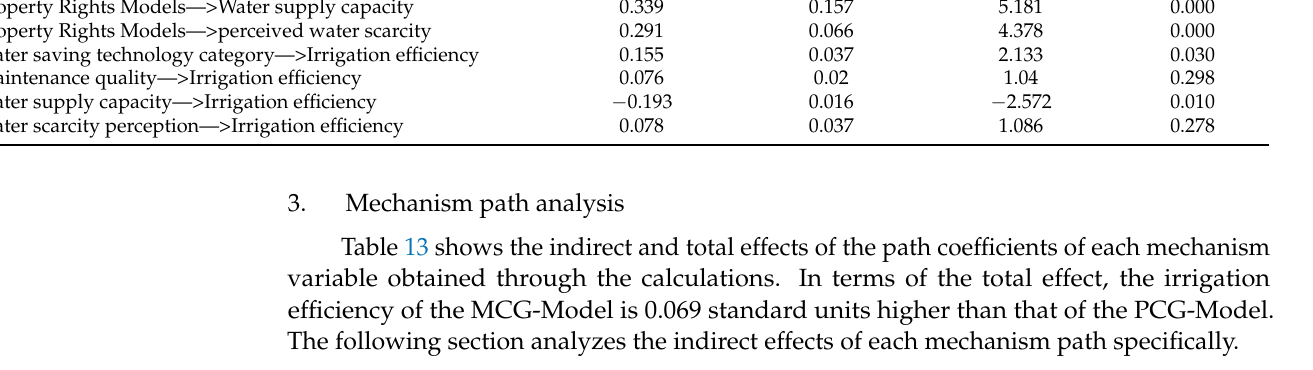
Figure 7. The path of action of the property rights development model on the impact of irrigation